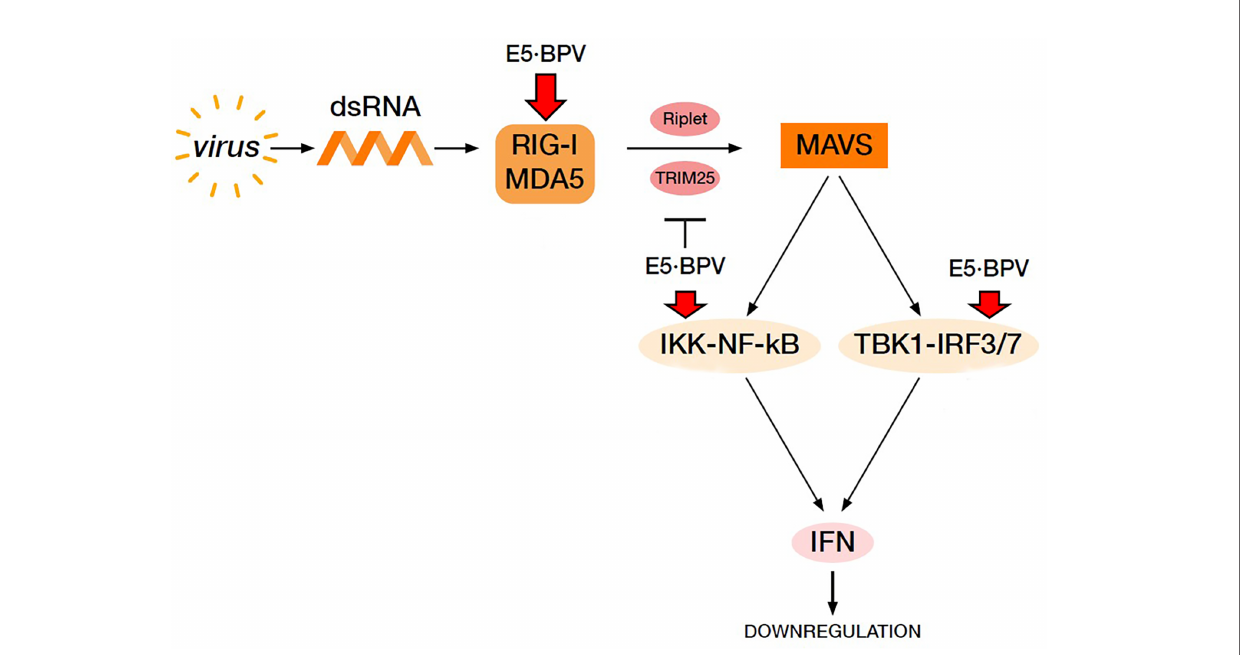
FIGURE 7 | Virus-mediated RIG-I and MDA5 signalling pathway resulting in IFN production. BPV E5 oncoprotein perturbs this pathway leading to a downregulation of IFN production thus contributing to cause a BPV persistent infection. Red arrows indicate downregulation of the proteins by BPV